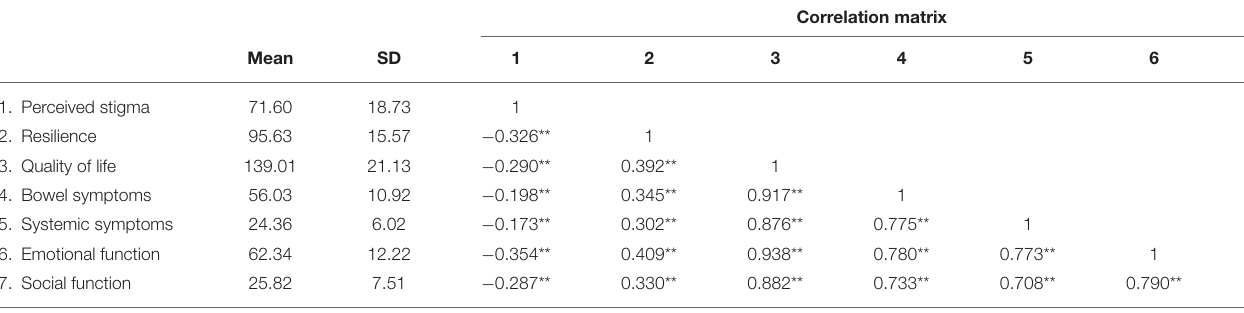
TABLE 2 | Levels and association of patients’ quality of life with perceived stigma and resilience ( N = 311).